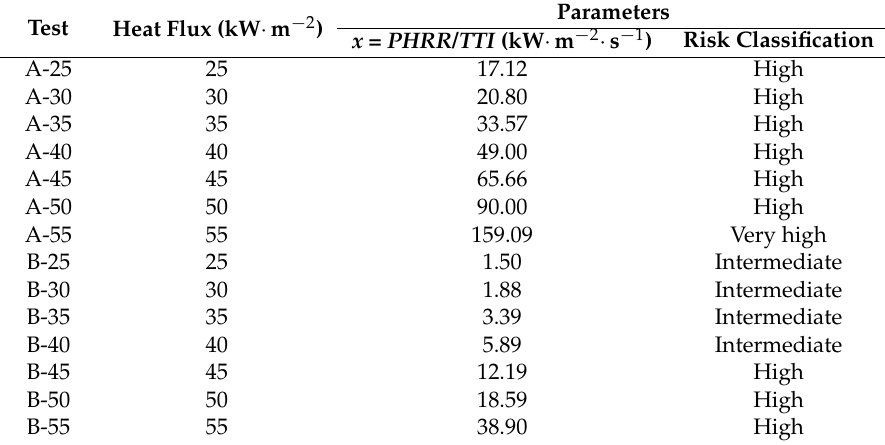
Table 2. Classification of fire hazard grade for material in different experimental